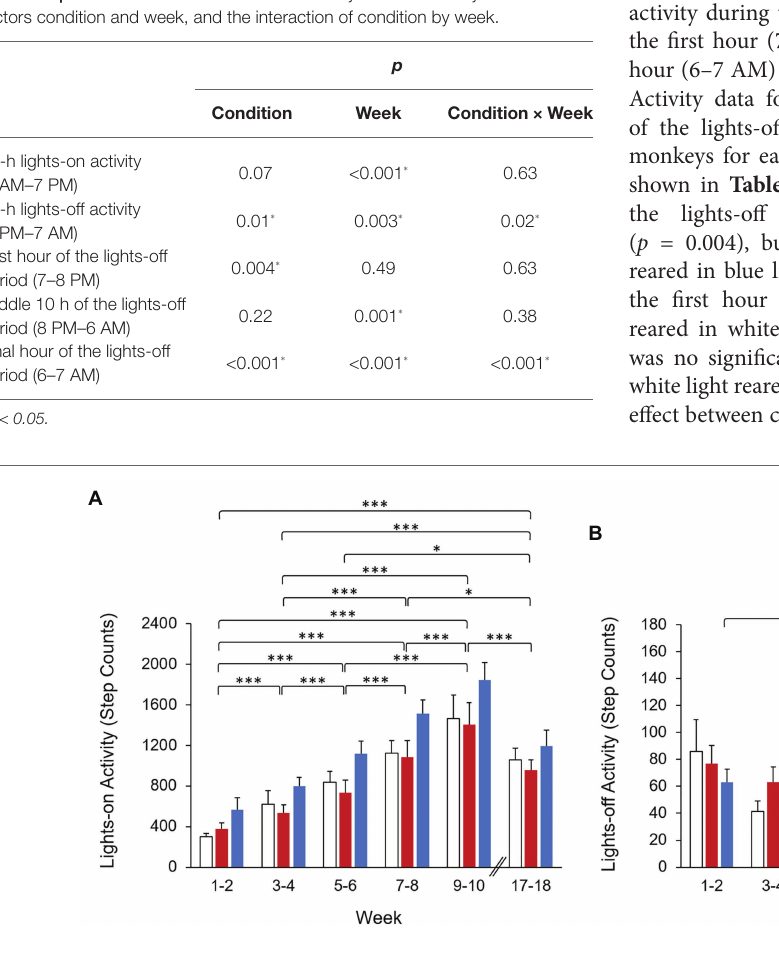
FIGURE 3 | Average activity (step counts) during the (A) 12-h lights-on period (7 AM–7 PM) and (B) 12-h lights-off period (7 PM–7 AM) by 2-week bins for monkeys reared in white light (open bars), red light (red bars), and blue light (blue bars). Activity during the lights-on period increased with age from weeks 1–2 to 9–10, but was not significantly different between monkeys reared in white, red, or blue light. During the lights-off period, monkeys reared in blue light exhibited significantly greater activity compared to monkeys reared in white light. Error bars represent SEM. * p < 0.05 and *** p < 0.001 for pairwise post hoc comparisons between weeks.